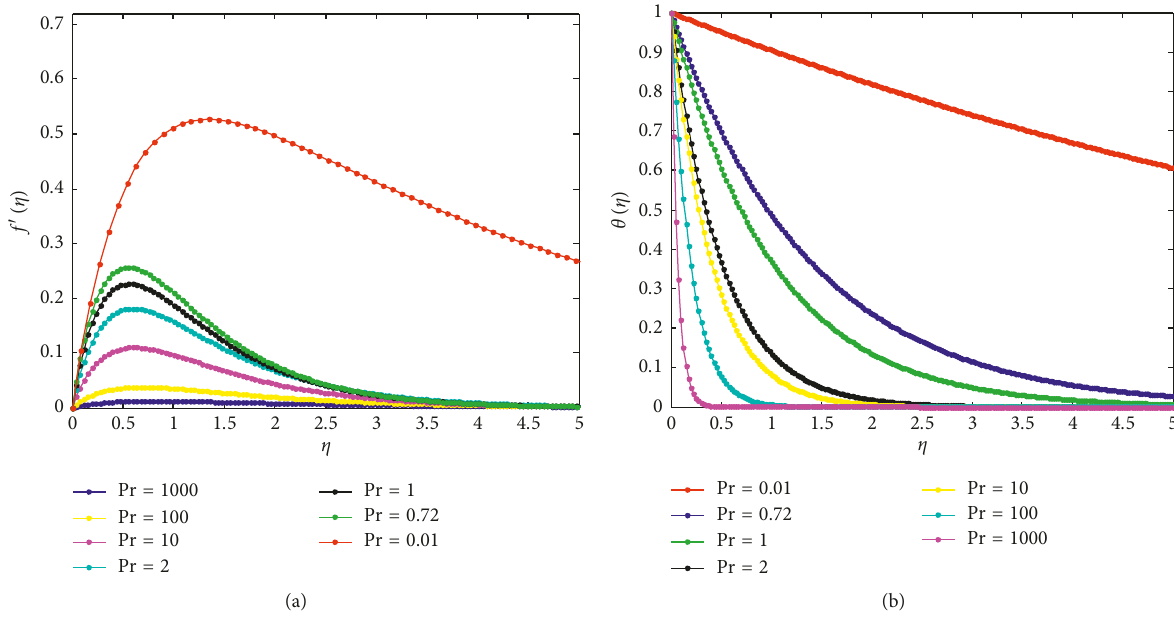
Figure 8: (a) Effects of Prandtl number on the velocity profile when ϕ � 0.060. (b) Effects of Prandtl number on the temperature profile when ϕ � 0.060.